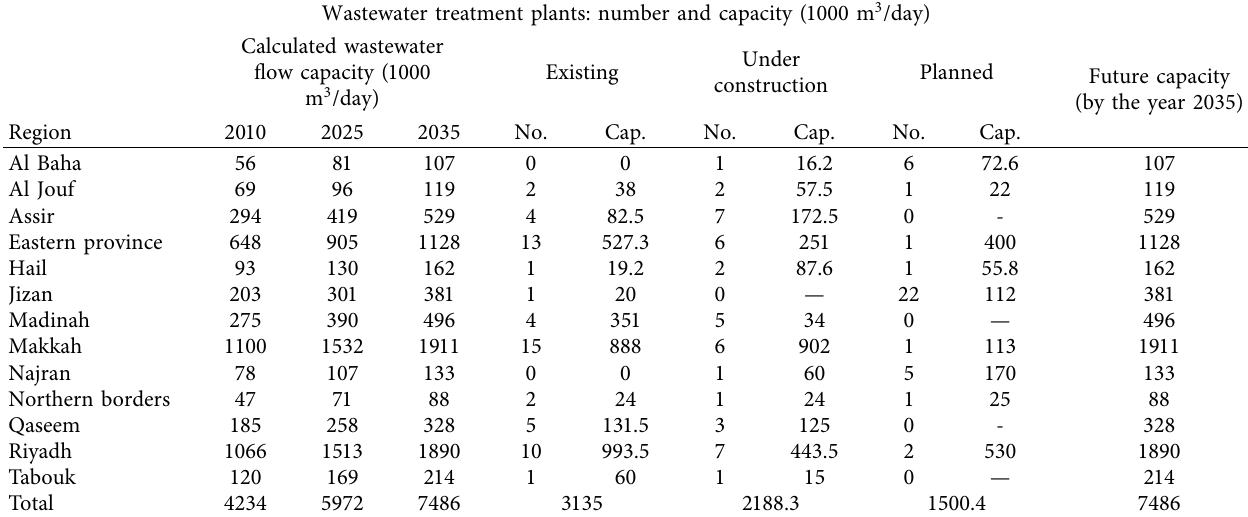
Table 1: Major wastewater treatment plants in Saudi Arabia (source: King Abdullah University of Science and Technology). Wastewater treatment plants: number and capacity (1000 m 3